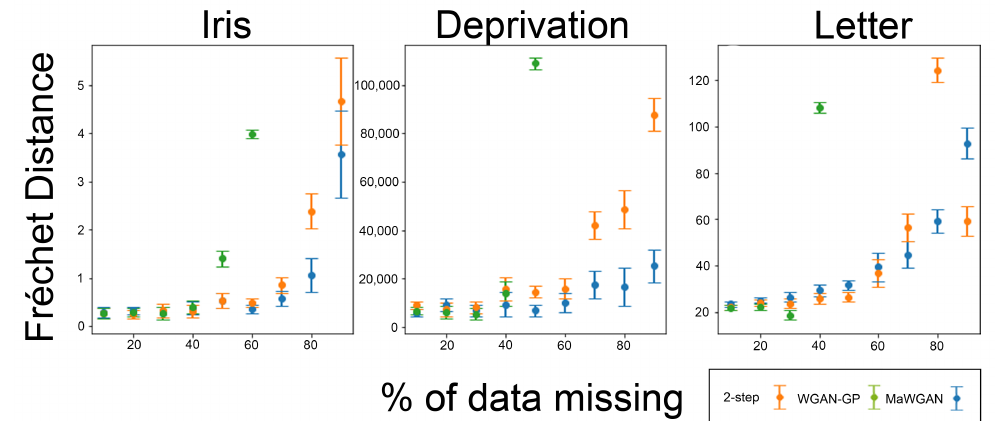
Figure 4. Fréchet distances for each method on the three datasets with different levels of missingness (lower is